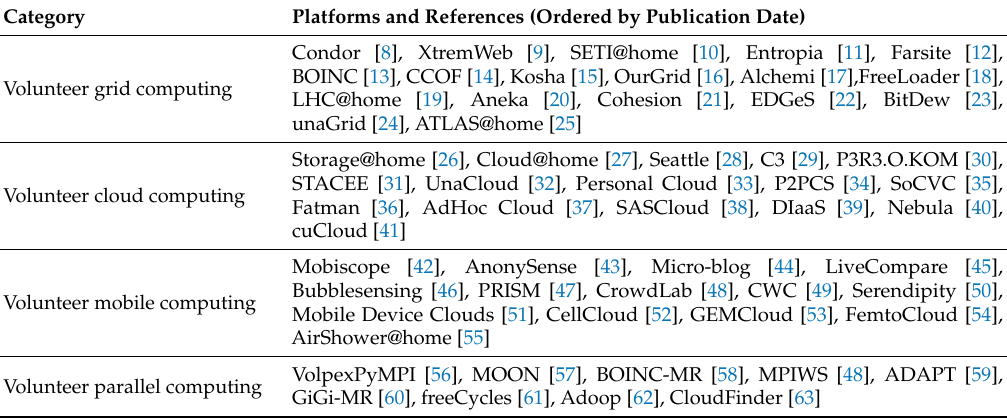
Table 1. Overview of some VC projects of recent years, data taken from [5]. Category Platforms and References (Ordered by Publication